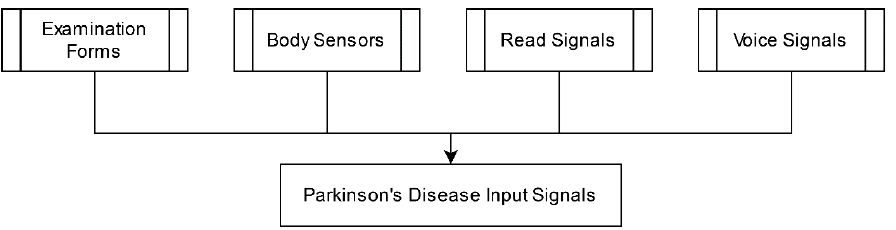
Figure 3. Various inputs to Parkinson’s Disease